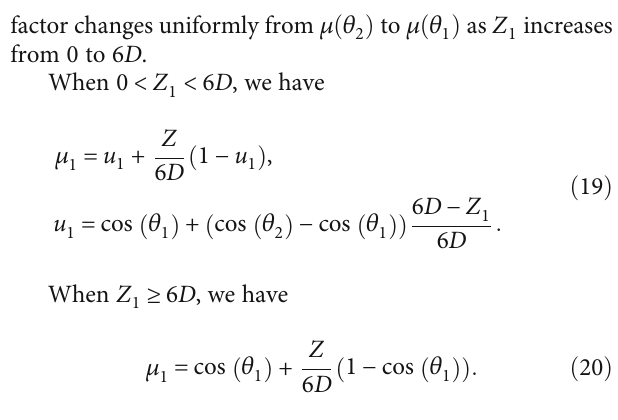
= 1 m. (b) Considering Z = 3 1 1